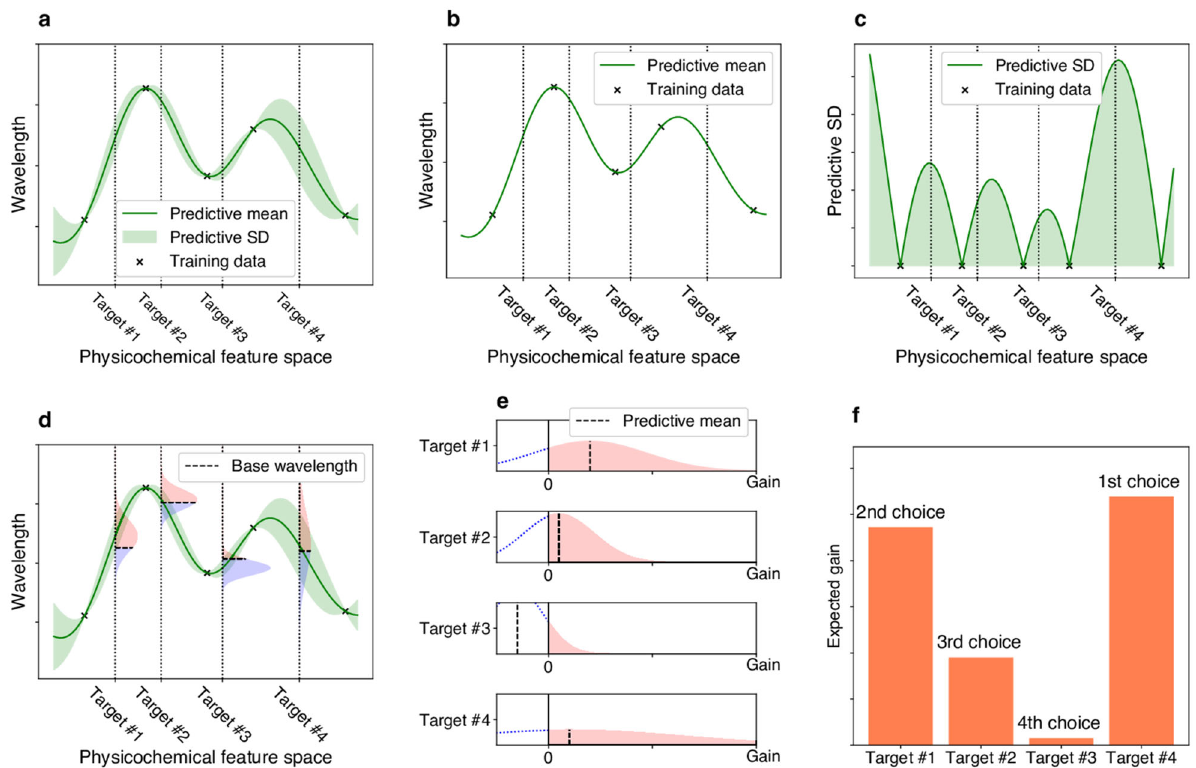
Fig. 2 Illustrations of exploration – exploitation for screening rhodopsins with red-shift gain. a Bayesian prediction model constructed using the current training data (black crosses). The prediction model is represented by the predictive mean and predictive standard deviation (SD). The horizontal axis schematically illustrates the space of proteins de fi ned through physicochemical features. The four vertical dotted lines indicate target proteins (candidates to synthesize). b Predictive mean. This function is de fi ned as the expected value of the probabilistic prediction by the Bayesian model. c Predictive SD. Since the predictive SD represents the uncertainty of the prediction, it has a larger value when the training data points do not exist nearby. d The distributions on the vertical dotted lines represent the predictive distributions, and the horizontal dashed lines are the base wavelengths of the target points. The base wavelength is different for each target point because it depends on the subfamily of the protein. e The density of the predictive distribution of each target protein on its red-shift gain value. The gain is de fi ned as the predicted wavelength subtracted by the base wavelength, and if it is negative, the value is truncated as 0. This can be seen as a “ bene fi t ” that can be obtained by observing the target protein. f Expected value of the red-shift gain. This provides a ranking list from which the next candidates to be experimentally investigated can be determined. Target #4 has the largest expected gain, although target #1 has the largest increase in the predictive mean compared with base wavelength in e . Because of its larger SD (as shown in a , c , d , and e ), target #4 is probabilistically expected to have a larger gain than the other